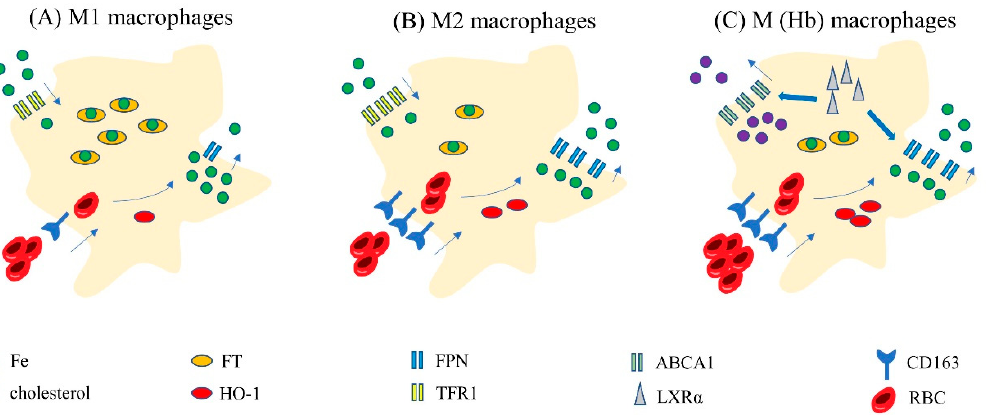
Figure 3. Characteristics of iron metabolism in M1, M2 and M (Hb) macrophages. ( A ) M1 macrophages; ( B ) M2 macrophages; ( C ) M(Hb) macrophages.